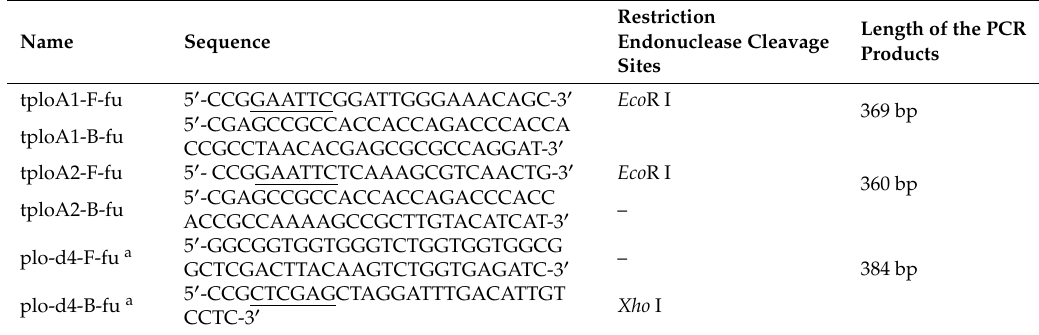
Table 1. Sequence of the PCR primers used in this